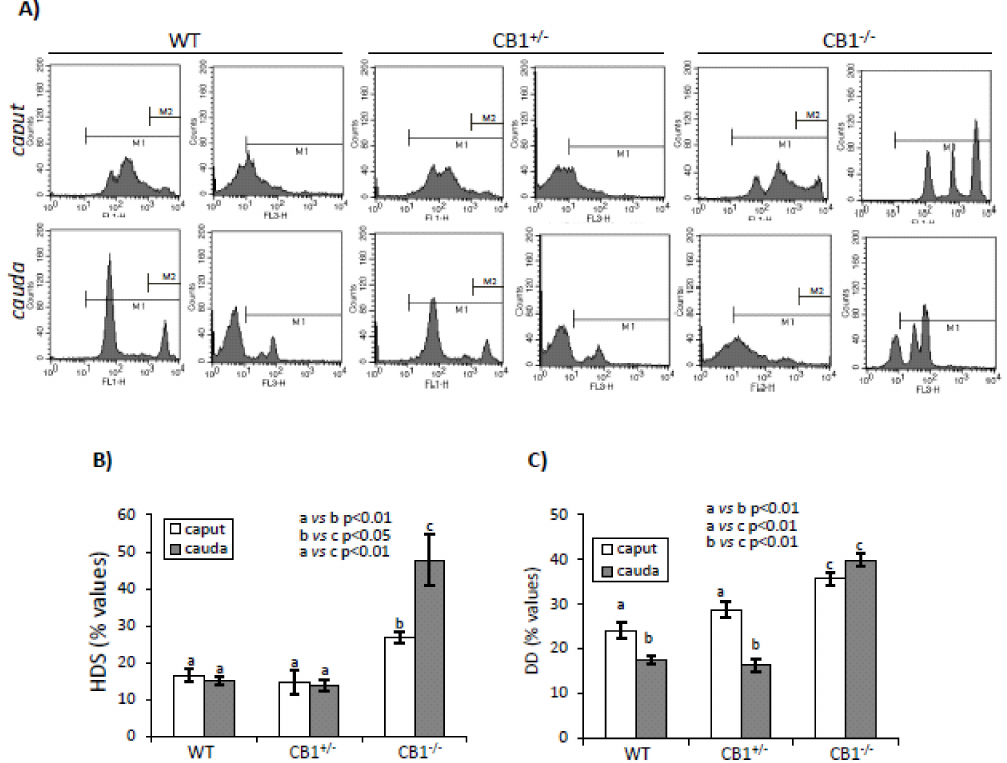
Figure 1. Flow cytometry analysis of sperm from caput and cauda epididymis of WT, CB1 +/ - , and CB1 - / - stained with AO. ( A ) Representative histograms of AO stained sperm in M1and M2 gate. Intensely green (FL1-H > 10 3 ), green (FL1-H > 10 1 ), red (FL3-H > 10 1 ) and total (green + red) fluorescencing DNA were used to analyze: ( B ) HDS (used as index of uncondensed chromatin) and ( C ) DD (used as index of DNA damage) values. Graphs were representative of four sperm samples / animal / genotype ( n = 4 animals for each genotype in triplicates). Data were expressed as the mean values ± S.E.M. Di ff erent letters indicated statistical significance ( p < 0.05 or p < 0.01).